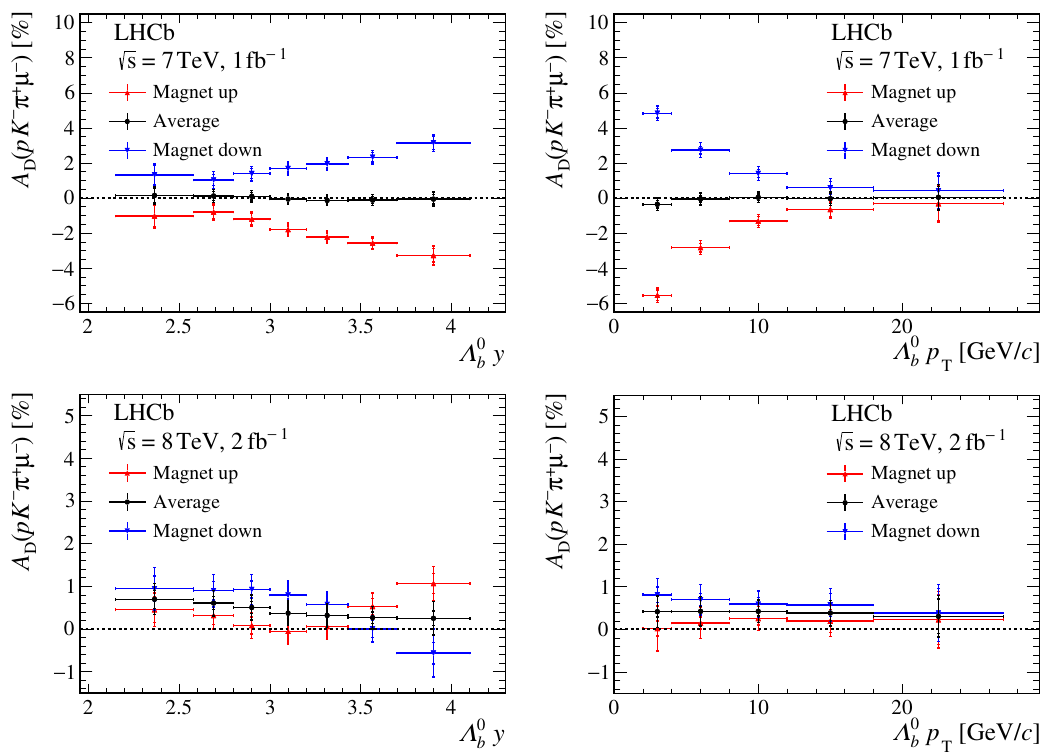
Figure 8 . Total correction due to detection asymmetries versus (cid:3) 0 p T for data taken at centre-of-mass energies of (top) p s = 7 TeV and (bottom) p s = 8 TeV. The results are shown separately for the (red upward triangles) magnet-up sample, (blue downward triangles) magnet-down sample and (black dots) their average. The first bar indicates the statistical uncertainty and the second bar the total